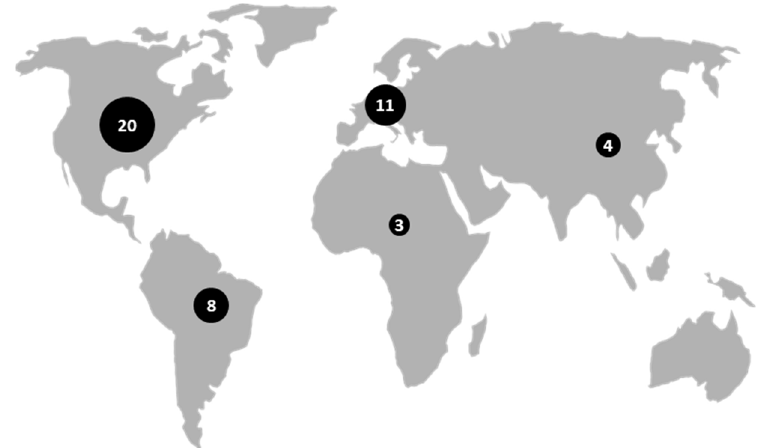
Figure 1. Number of studies by region.